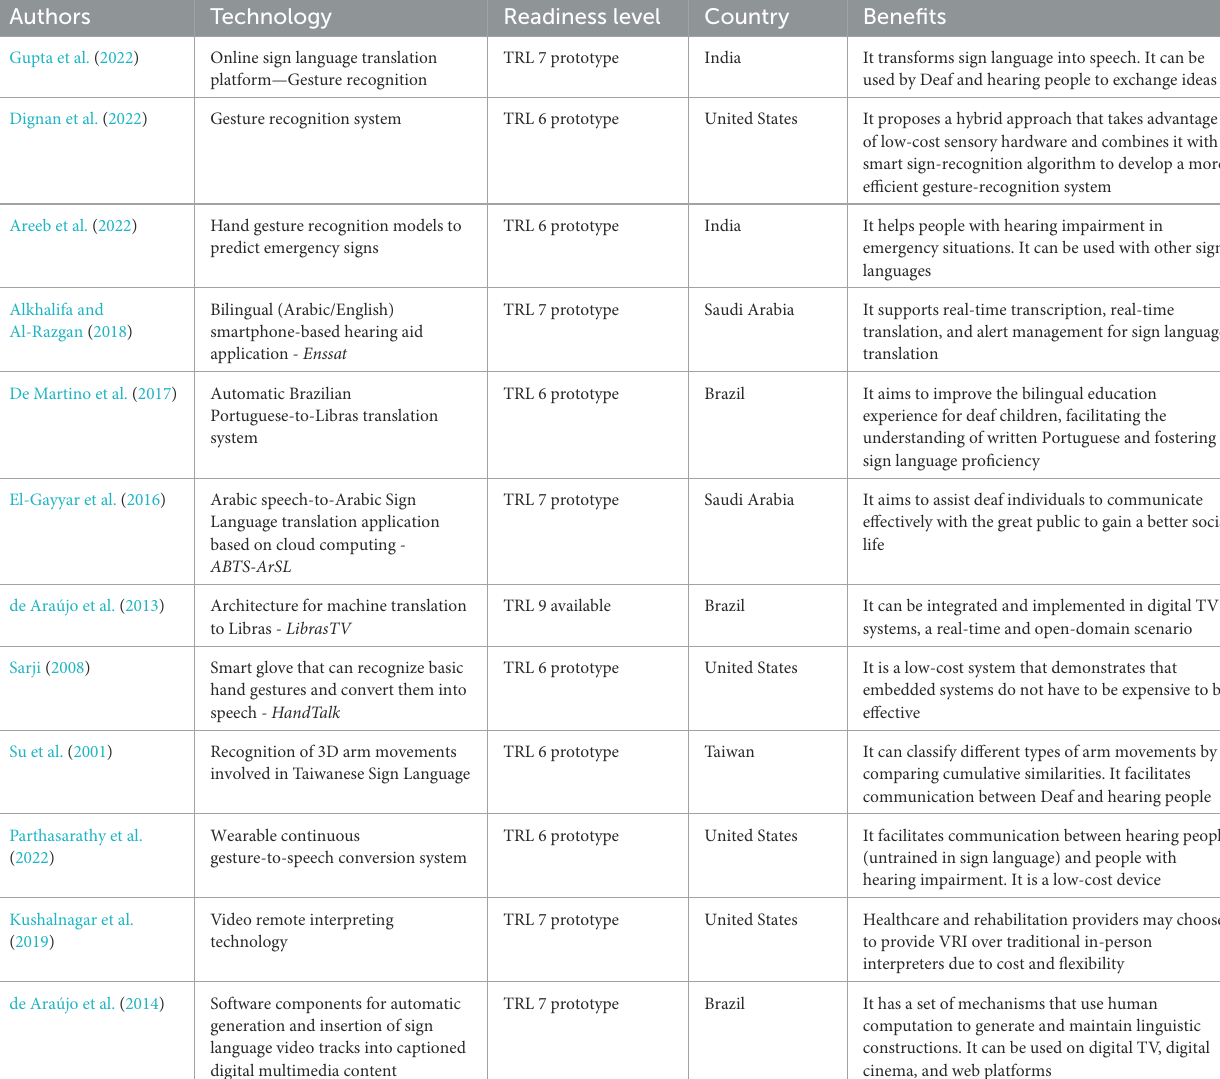
TABLE 2 Technologies based on gesture recognition for the translation of sign language into speech and vice